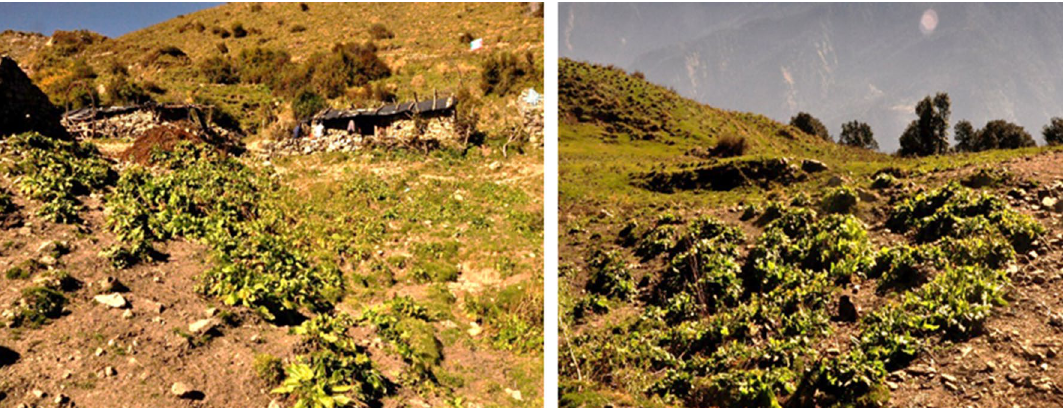
Figure 4. Colonization of Rumex nepalensis distributed in the Dayara bugyal.